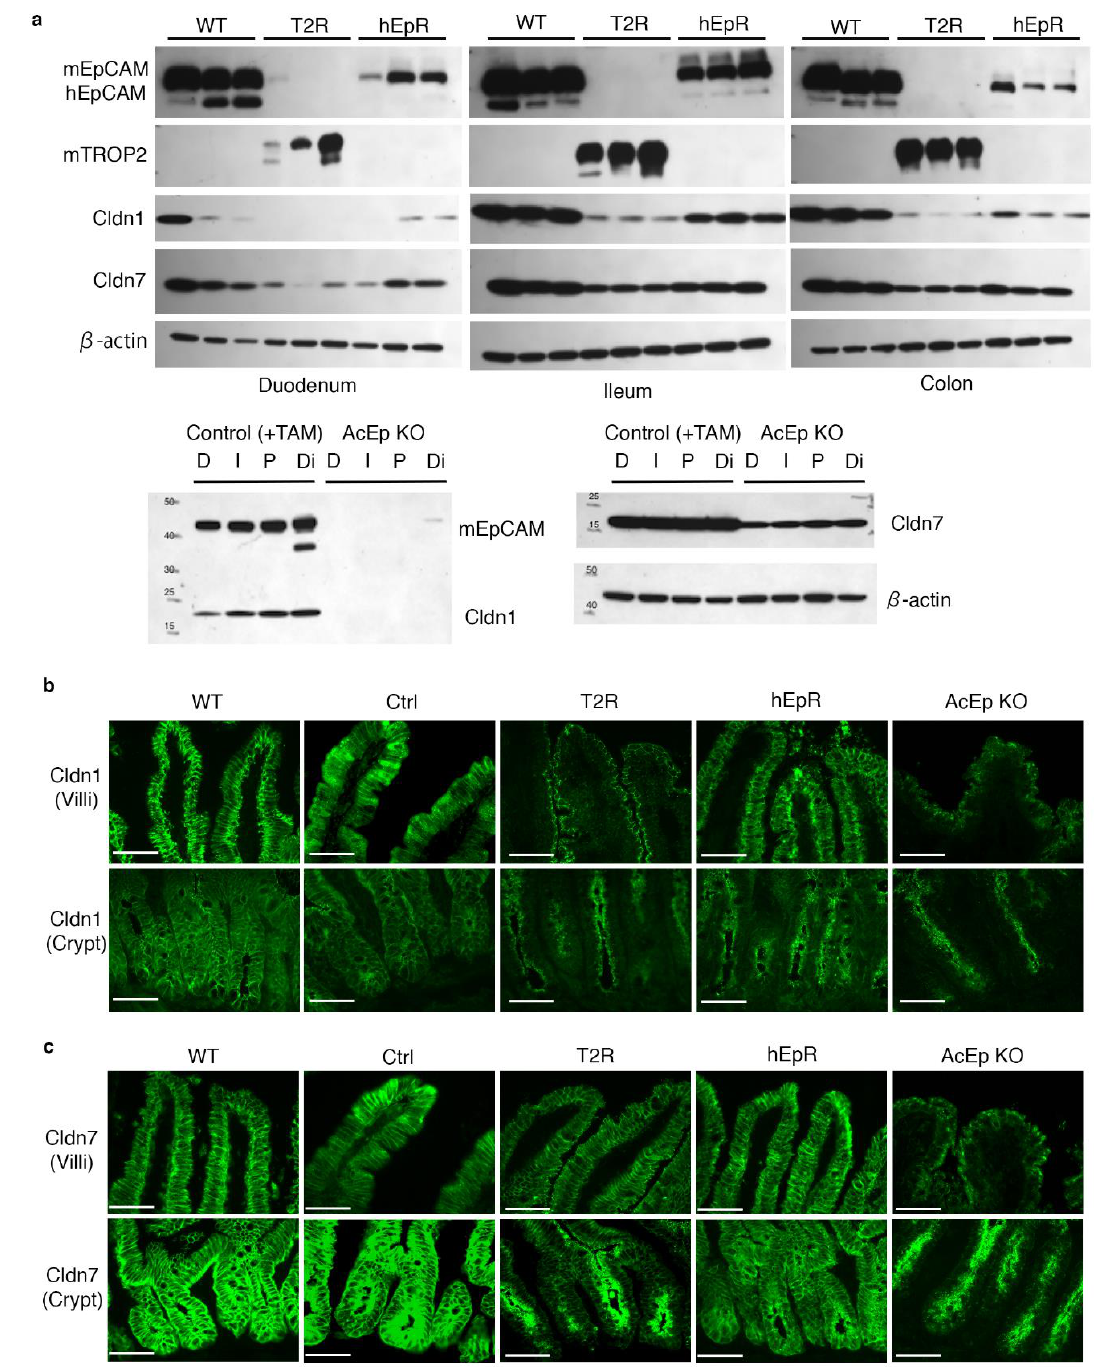
Figure 7. Decreased expression and mislocalization of claudin-1 and claudin-7 in TROP2 rescue mice. ( a ) Normalized amounts of intestinal tissue lysate proteins were resolved using SDS-PAGE and immunoblotted with anti-hEpCAM, anti-mEpCAM, anti-mTROP2, anti-claudin-1, anti-claudin-7, and anti- β -actin. Specific proteins were detected with HRP-labeled secondary Ab and chemiluminescence. D: Duodenum, I: Ileum, P: Proximal colon, Di: Distal colon, and TAM: tamoxifen treated. ( b ) Claudin-1 was detected and localized via immunostaining in ileum villi and crypts of relevant mice. Claudin- 1, green. Scale bars, 50 μm. ( c ) Claudin-7 was detected and localized via immunostaining in ileum villi and crypts of relevant mice. Claudin- 7, green. Scale bars, 50 μm.